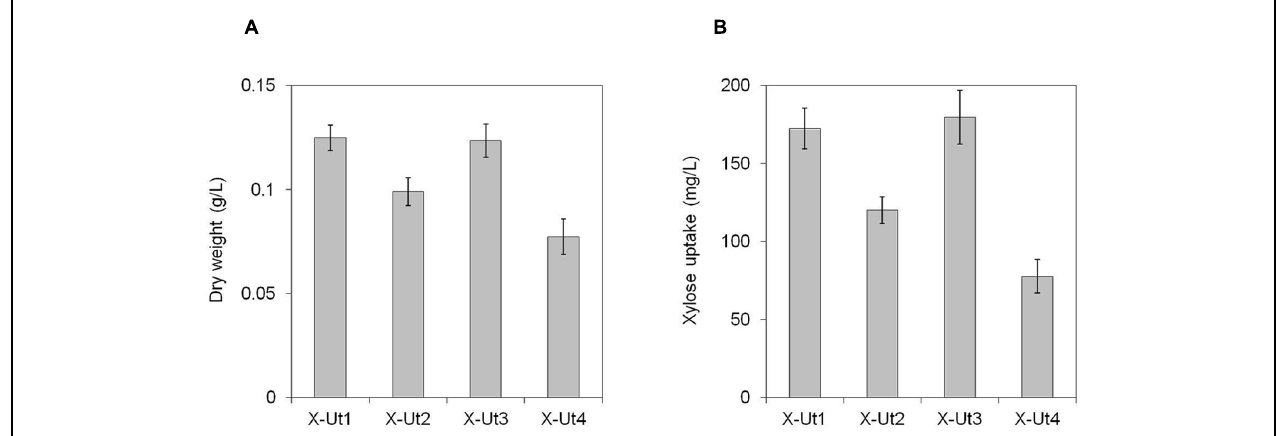
FIGURE 7 | Growth and xylose consumption under LAHG conditions in the presence of 5 mM xylose. Synechocystis strains X-Ut1, X-Ut2, X-Ut3, and X-Ut4 were grown in the presence of 5 mM (750 mg/L) xylose. (A) Dry biomass values estimated at the end of the seventh day. (B) Xylose consumption at the end of the seventh day exhibited by the transformant strains, determined from the measurement of residual xylose in the cell-free medium. Data were collected from three biological replicates and are presented as means ± standard deviations.